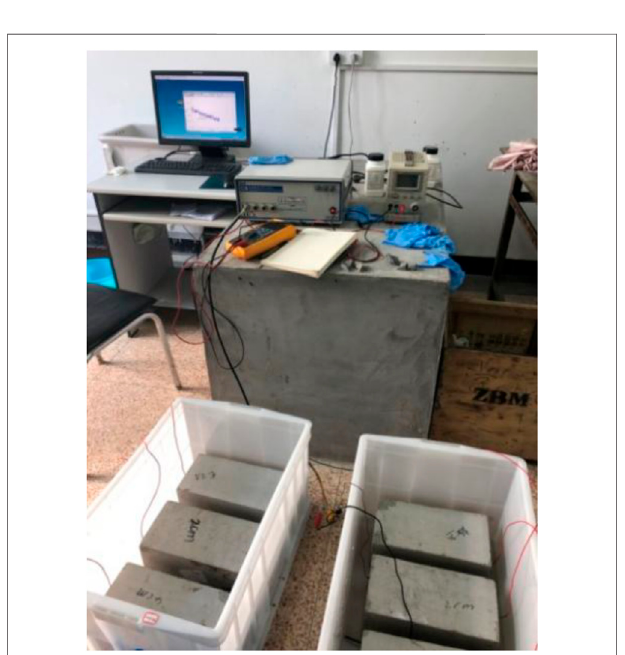
FIGURE 5 | Accelerated corrosion method and measurement of electric polarization